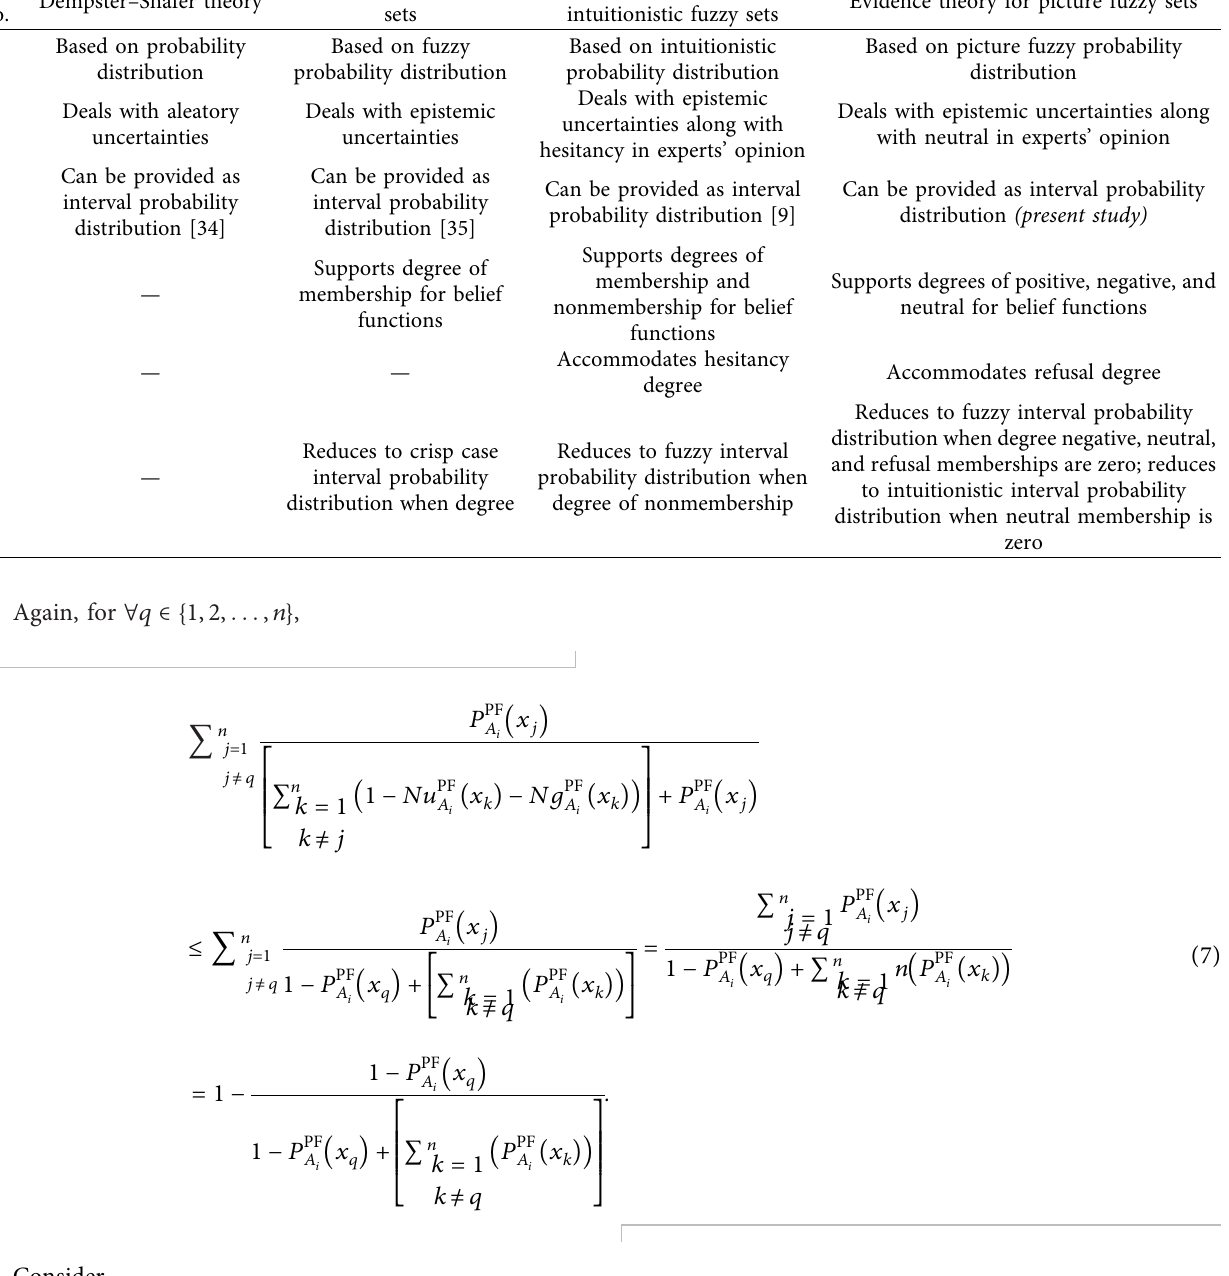
Table 1: Comparison of the proposed approach with DST, fuzzy, and intuitionistic approaches.